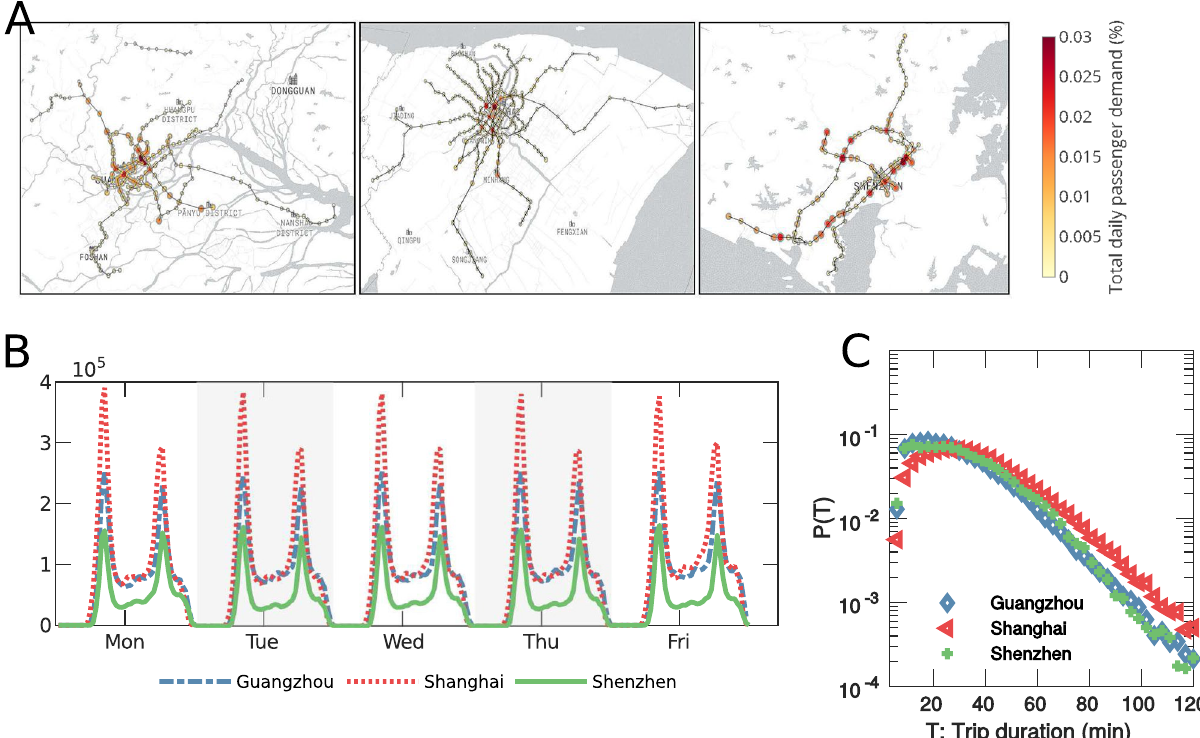
for the metro network layout were created using mplleaflet library in Python3, which can be accessed at https ://githu b.com/jwass /mplle aflet . ( B ) Temporal distribution of metro ridership obtained from the smart